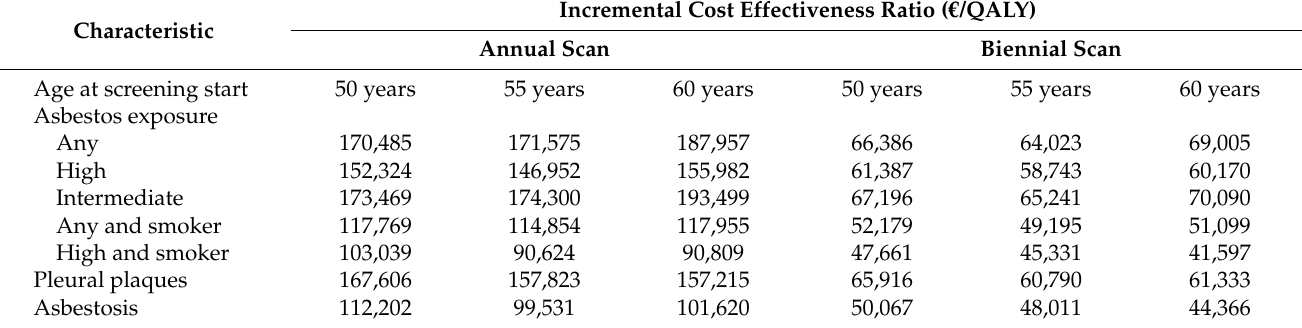
Table 5. Incremental Cost Effectiveness Ratios (ICERs) for the Different Screening Strategies Accord- ing to Population Characteristics (lifetime horizon and discount rate of 3% per annum).